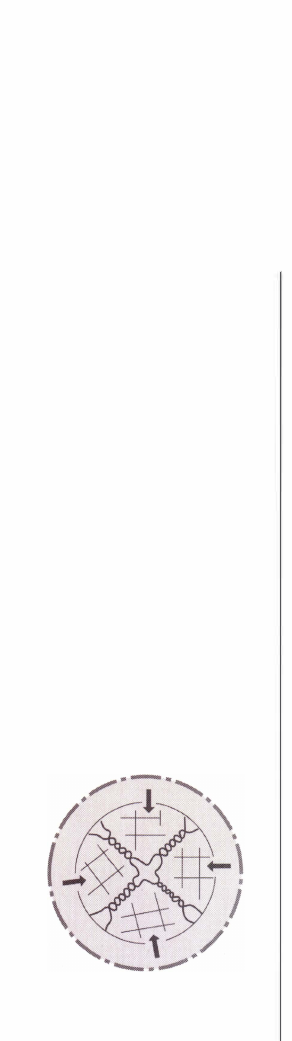
Fig. 5: Gel strengths of 2.5 % agarjwater gels dissolved at different